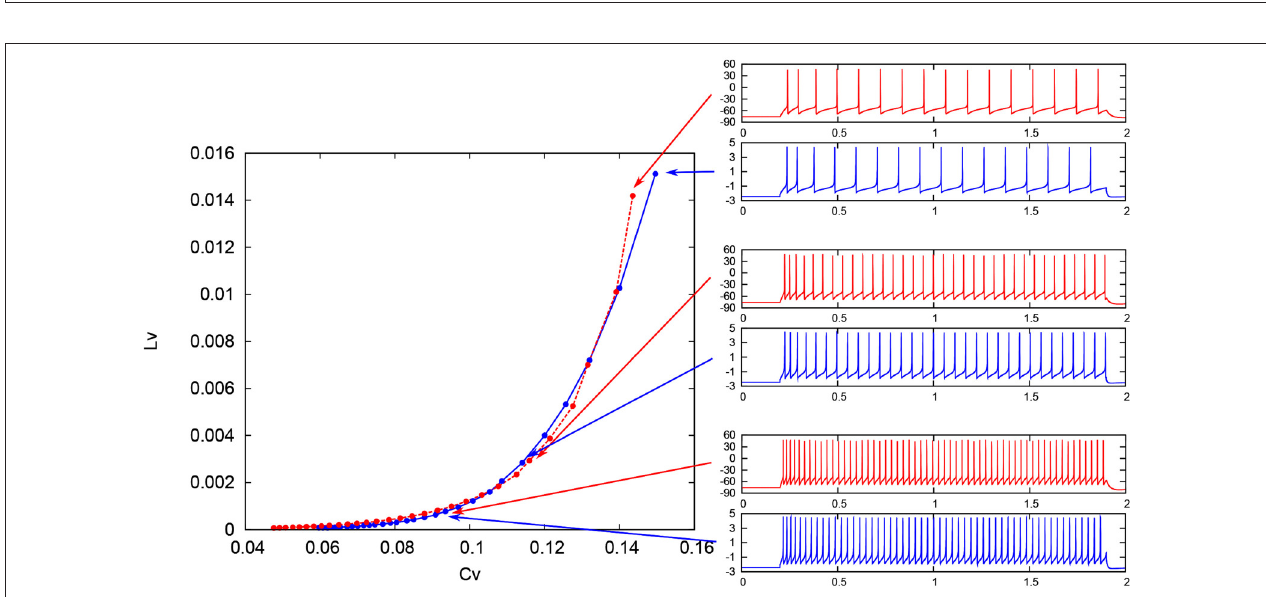
Frontiers in Neuroscience |